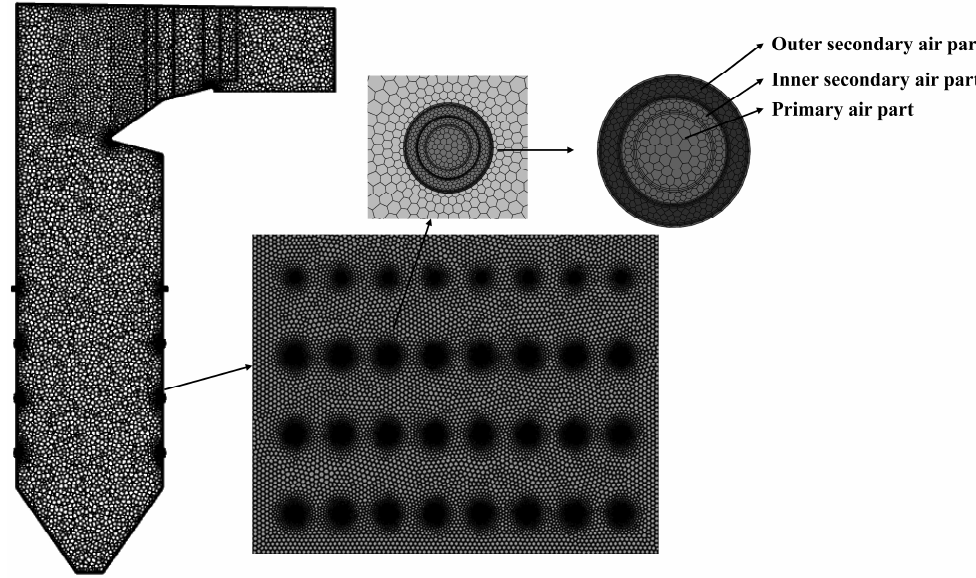
Figure 4. Grid system of the 1000 MW USC boiler. Table 1. Operating conditions of the boiler for 100% and 75% load cases.